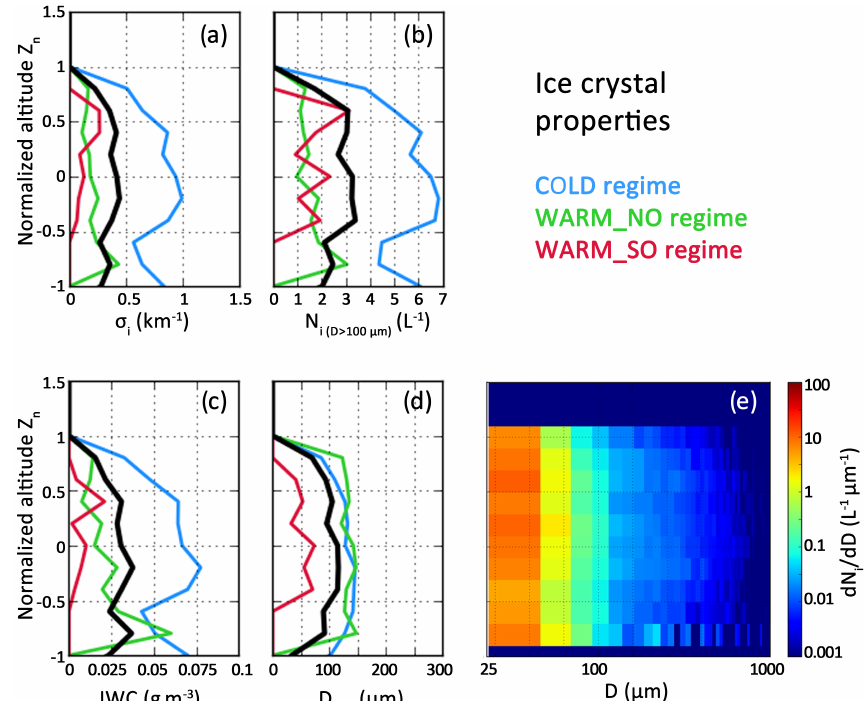
Figure 5. Vertical profiles (expressed in normalized altitudes) of ice crystal properties from CPI measurements (15µm–2.3mm size range): (a) extinction coefficient, (b) ice crystal concentration, (c) IWC, (d) effective diameter for the three regimes and averaged over all the campaigns and (e) averaged particle size distribution for all the